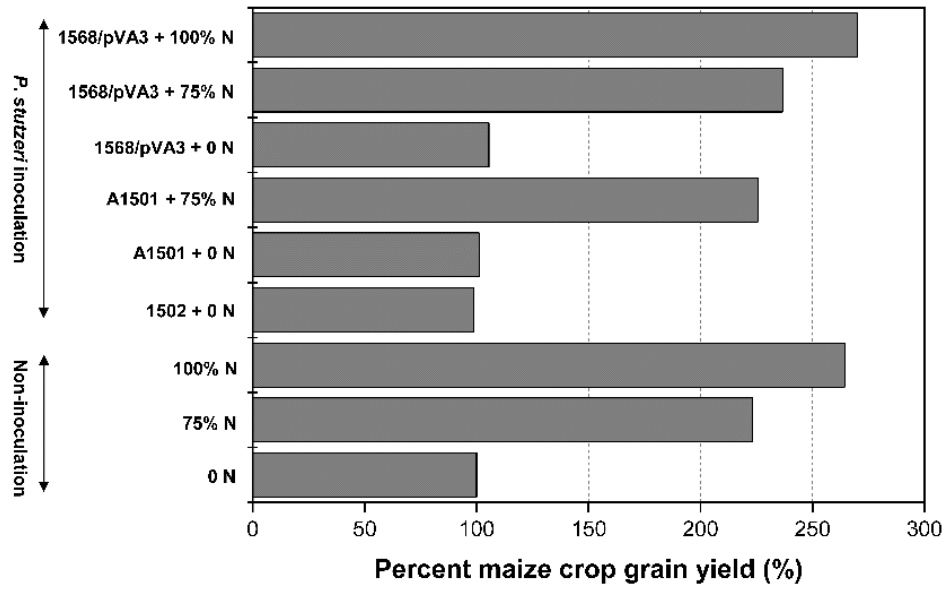
Figure 3. Effect of P. stutzeri inoculation on the grain yield of maize in the field experiment. 0 N, 0 kg of N ha −1 , maize plants neither fertilized with urea nor inoculated with strains were considered as control (100%); 75% N, 75 kg of N ha −1 ; 100% N, 100 kg of N ha −1 ; 1502 + 0 N, 0 kg of N ha −1 plus inoculation with nifH -mutant 1502; A1501 + 0 N, 0 kg of N ha −1 plus inoculation with wild-type A1501; A1501 + 75% N, 75 kg of N ha −1 plus inoculation with wild-type A1501; 1568/pVA3 + 0 N, 0 kg of N ha −1 plus inoculation with ammonium-excreting strain 1568/pVA3; 1568/pVA3 + 75% N, 75 kg of N ha −1 plus inoculation with 1568/pVA3; 1568/pVA3 + 100% N, 100 kg of N ha −1 plus inocula- tion with 1568/pVA3. The values are mean ± standard deviation (n = 20). Table 5. Shoot height (SH), shoot dry weight (SDW), shoot N concentrations (NC), length (LL) and width (WL) of leaf, diameter of shoot (DS), the row numbers per ear (RN) and grain numbers per row (GN), thousand seed weight (TSW) and grain yield (GY) of maize plants from the field experi- ment. 0 N, 0 kg of N ha −1 ; 75% N, 75 kg of N ha −1 ; 100% N, 100 kg of N ha −1 . The values are mean ± standard deviations (n = 20). Different letters (a-f) indicate a significant difference ( p < 0.05) accord- ing to ANOVA analysis. Inoculant Treat- ments